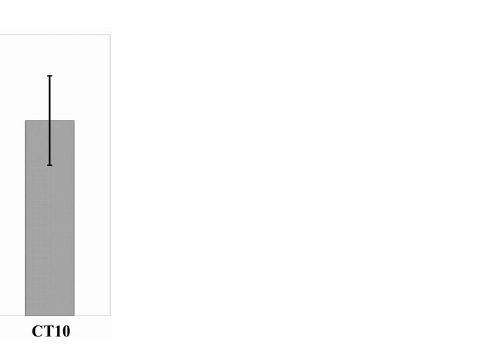
Figure 5. The total biofilm mass (represented as an optical density value at 570 nm) on the surface of the uncoated NiTi alloy sample and the GO/AgNPs coated NiTi alloy samples using different coating times.